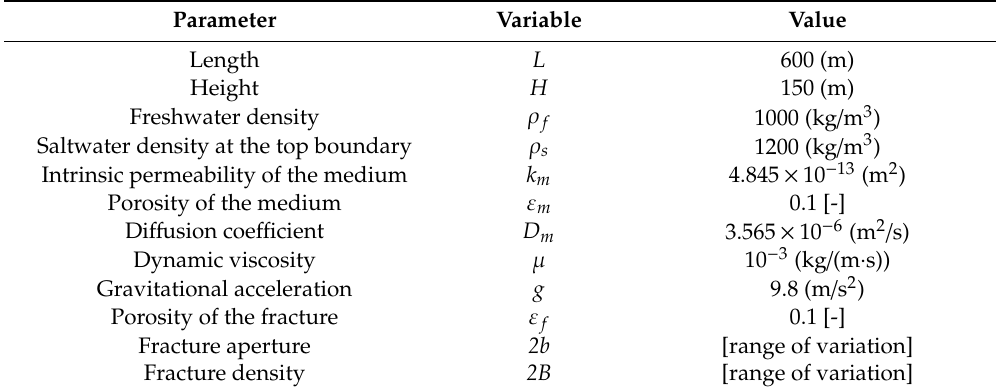
Table 1. Physical parameters used in COMSOL for the fractured Elder problem (Rayleigh number ( Ra ) = 400).